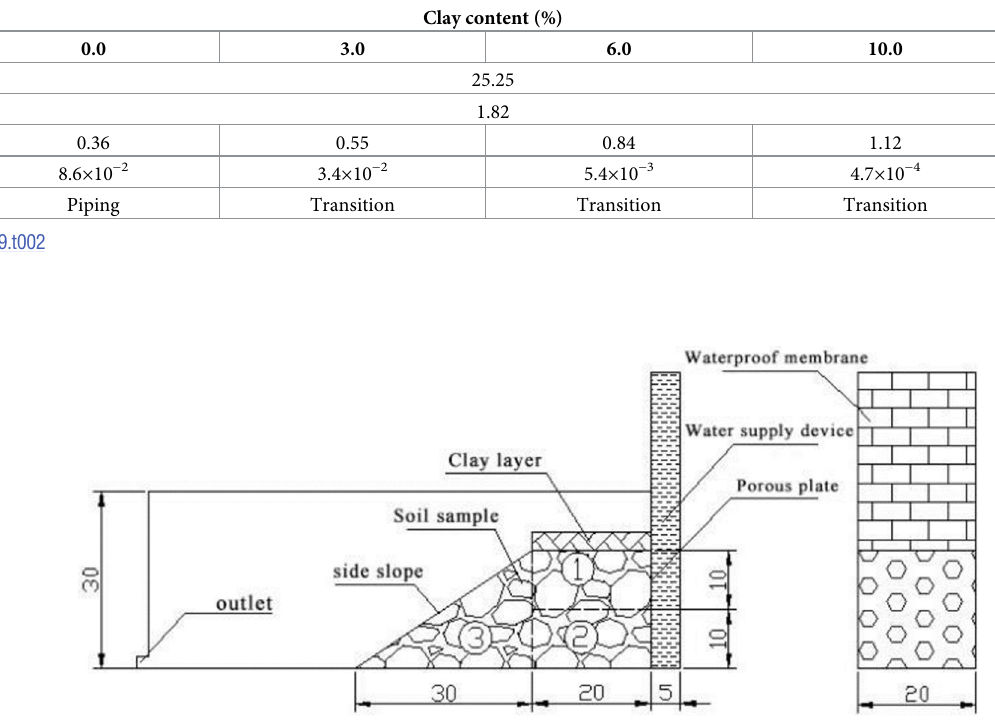
Table 2. Results of the seepage tests with different clay contents.